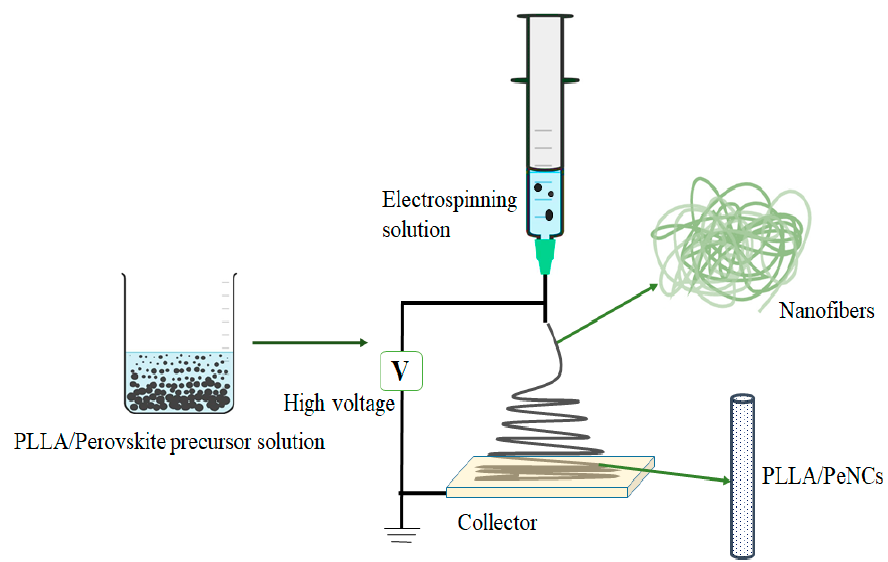
Figure 1. Schematic of electrospinning set-up for the fabrication of perovskite NCs–PLLA nano- fibres.